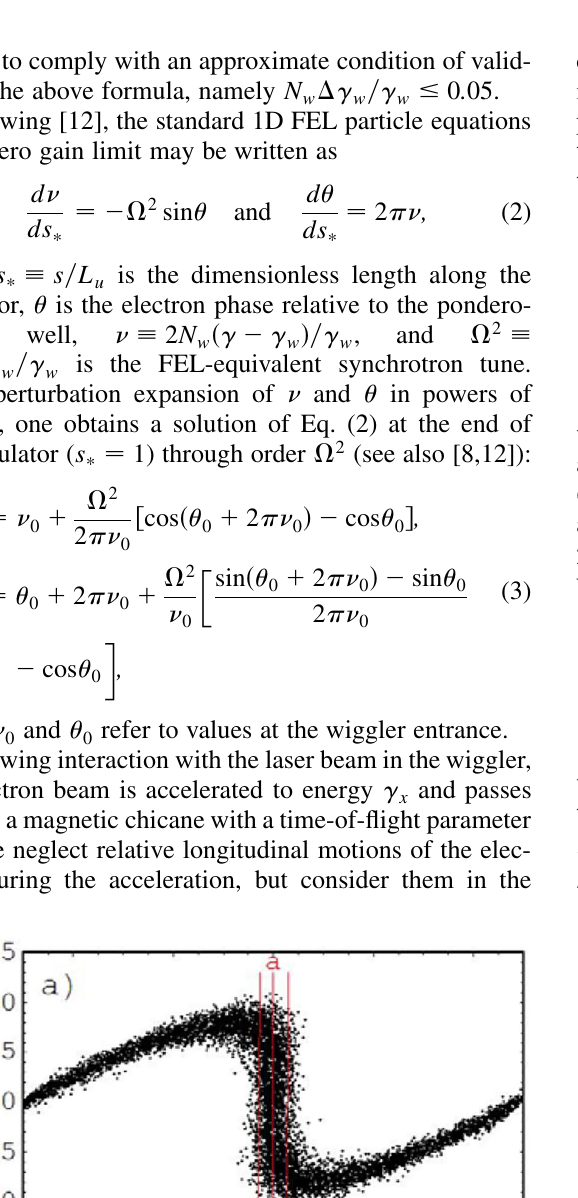
FIG. 1. (Color) A schematic of ESASE x-ray